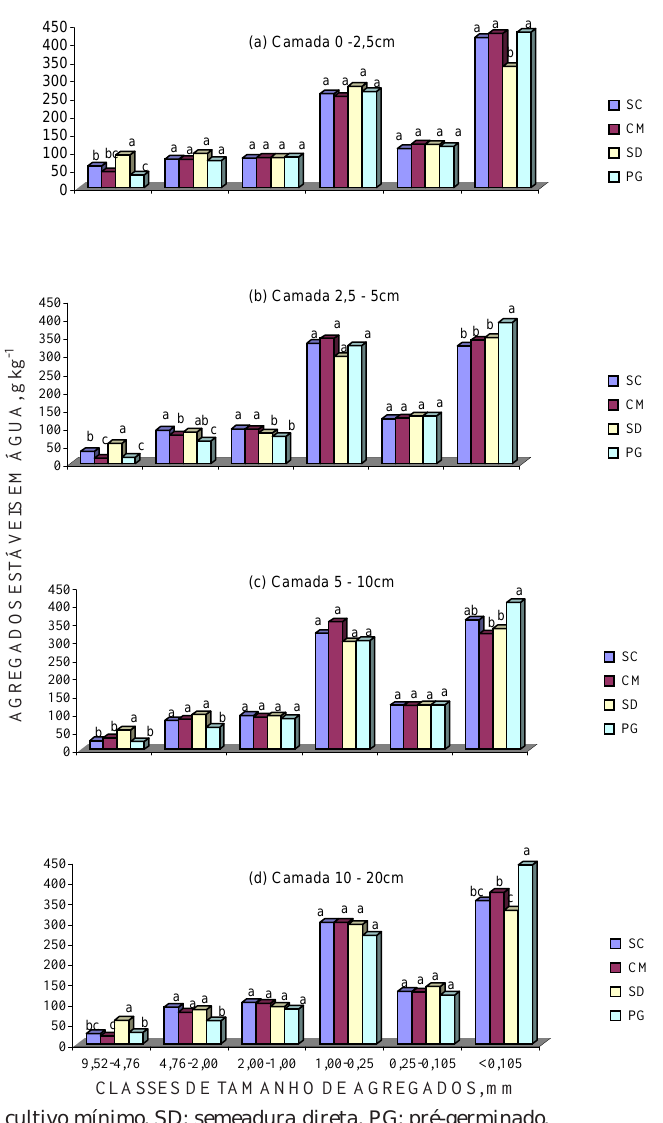
Figura 1. Valores médios de agregados estáveis em água em diferentes classes de distribuição de tamanho de um Planossolo, considerando sistemas de manejo e camadas. Valores seguidos pela mesma letra dentro de cada classe, não diferem significativamente pelo teste de Duncan a 5